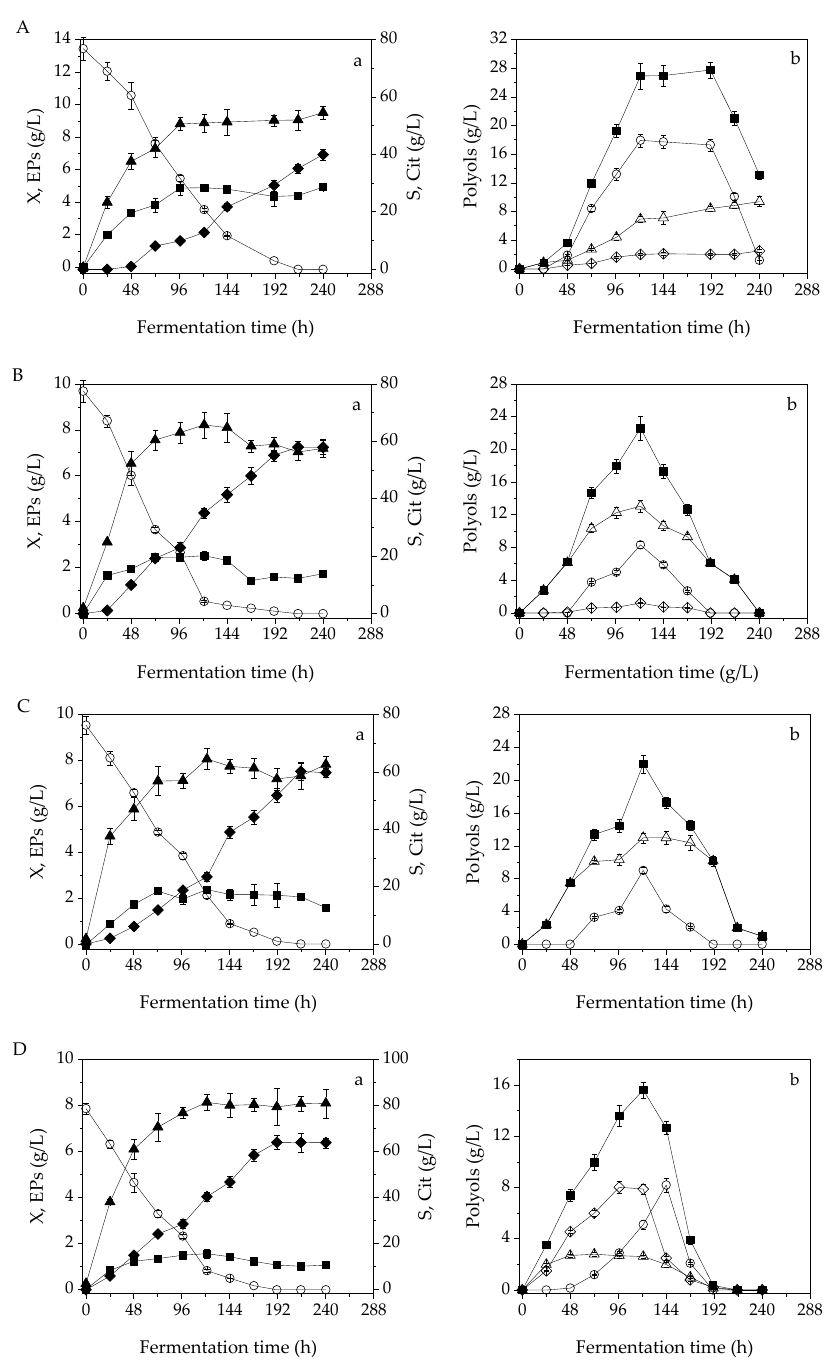
Figure 1. Kinetics of (a) biomass (X, g/L, ▲ ) and endopolysaccharides (EPs, g/L, ■ ) and citric acid (Cit, g/L, ◆ ) production, as well as glycerol (S, g/L, ○ ) consumption and (b) total polyols (g/L, ◼ ), mannitol (g/L, △ ), arabitol (g/L, ◇ ), erythritol (g/L, ○ ) production during shake-flask fermentations of Y. lipolytica LMBF Y-46 when 0 g/L ( A ), 1 g/L ( B ), 2 g/L ( C ), 3 g/L ( D ) of phenolic compounds were applied in shake-flask nitrogen-limited media. The culture conditions were: 250 mL Erlenmeyer flasks filled up to 50 mL at 180 rpm, initial pH = 6.0, pH ranging between 4.8 and 6.0, incu- bation temperature T = 28 °C, initial glycerol concentration of 77.9 ± 0.52 g/L.